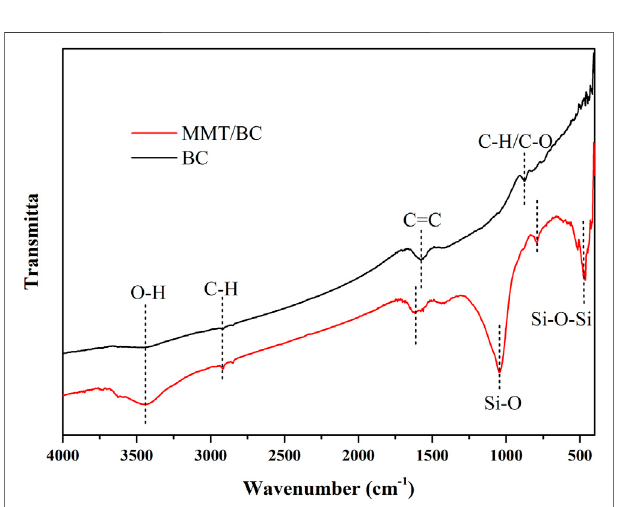
FIGURE 1 | SEM images of BC (A) and MMT/BC (B) ; TEM images of BC (C) and MMT/BC (D) .